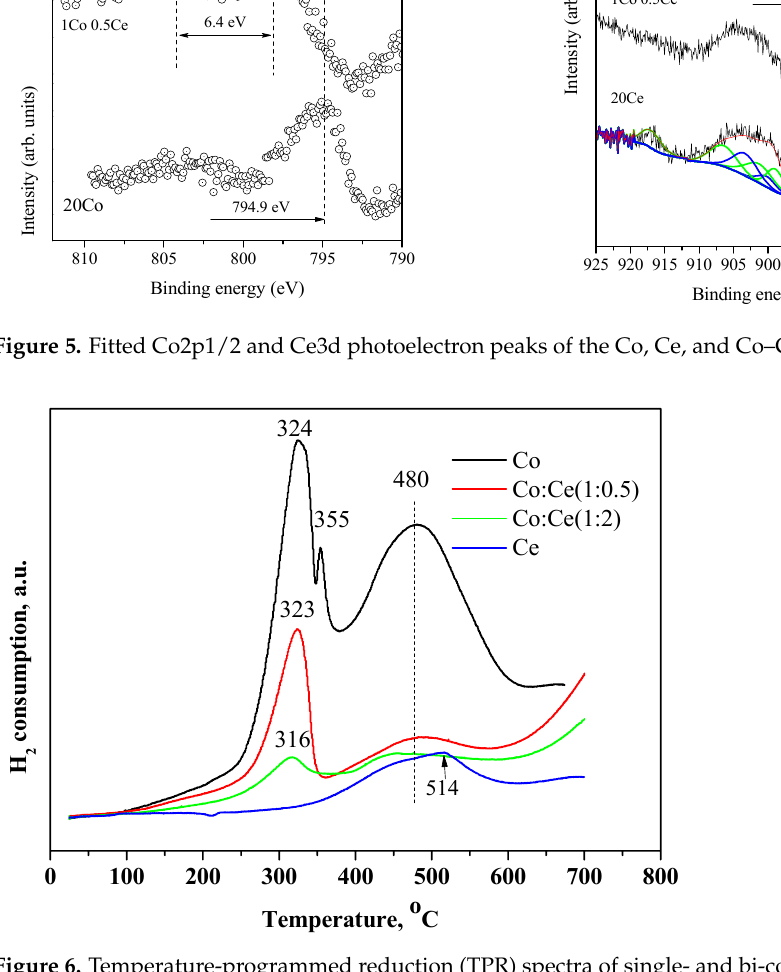
Figure 6. Temperature-programmed reduction (TPR) spectra of single- and bi-component cata- lysts.